Question: Express in one sentence what the figure is showing.
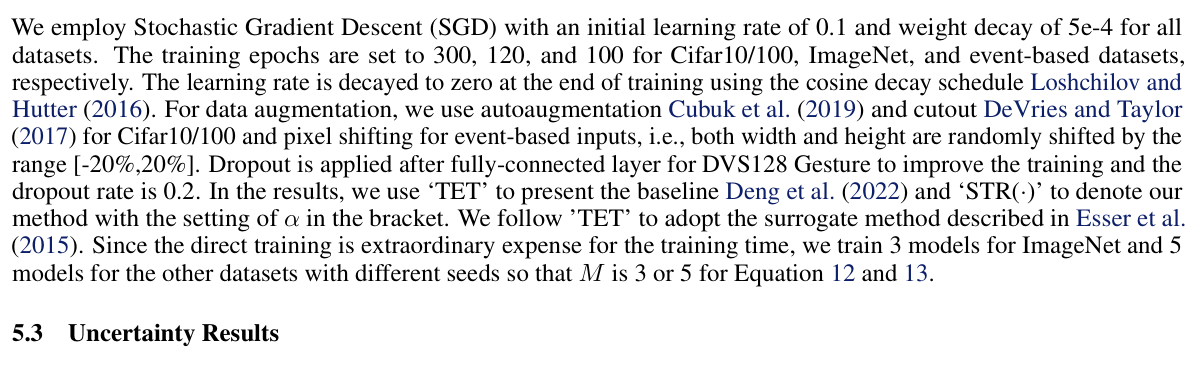
Answer: depicts the estimated uncertainty of predictions on different datasets, which reveals interesting patterns of uncertainty trends as time evolve. Specifically, it can be observed that the predictions at initial timestep tend to exhibit large uncertainty on most datasets, and then gradually reduces. This shows predictions becomes more reliable as the timestep increases. But we also notice that such trend is not obvious on the N-Caltech101 dataset, as shown in Figure